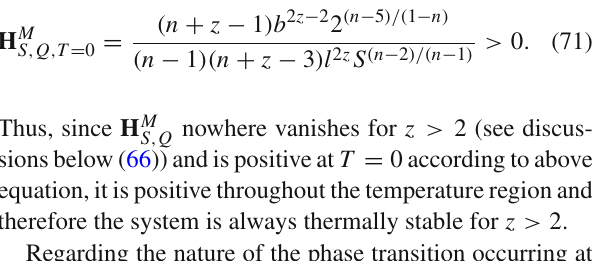
the system is always thermally stable . For Q < Q c , there are three divergences; one at T = 0, one at T < T c and